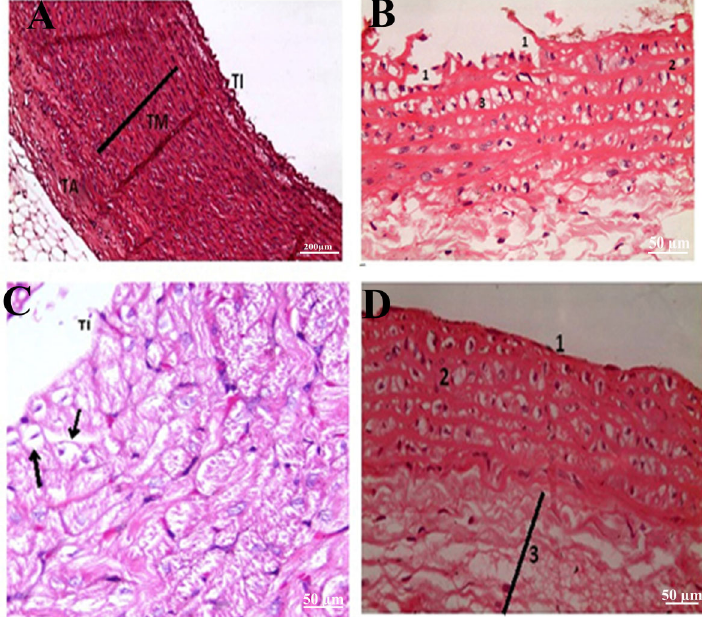
Figure 5. Histological changes of aortas of rats experimentally induced with atherosclerosis. A , Control group: three layers forming wall of aorta: tunica intima (TI), tunica media (TM) formed of concentrically-arranged smooth muscle, and tunica adventitia (TA) (H&E, (cid:1) 200, scale bar 200 m m). B , Atherosclerotic group: desquamation and destruction of tunica intima with underlying lamina propria (1); tunica media shows a deposition of fat (2) with appearance of foam cells (3) (H&E, (cid:1) 400, scale bar 50 m m). C , Stem cells-treated group: the slide shows normal appearance of the TI with no desquamation, TM appears with normal thickness with very little fat in fi ltration (head of black arrow) and no detected foam cells (H&E, (cid:1) 400, scale bar 50 m m). D , Resveratrol-treated group: TI appears intact with no destruction or desquamation (1). Presence of foam cells in the TM (2) and increased thickness of the TA (3) (H&E (cid:1) 400, scale bar 50 m